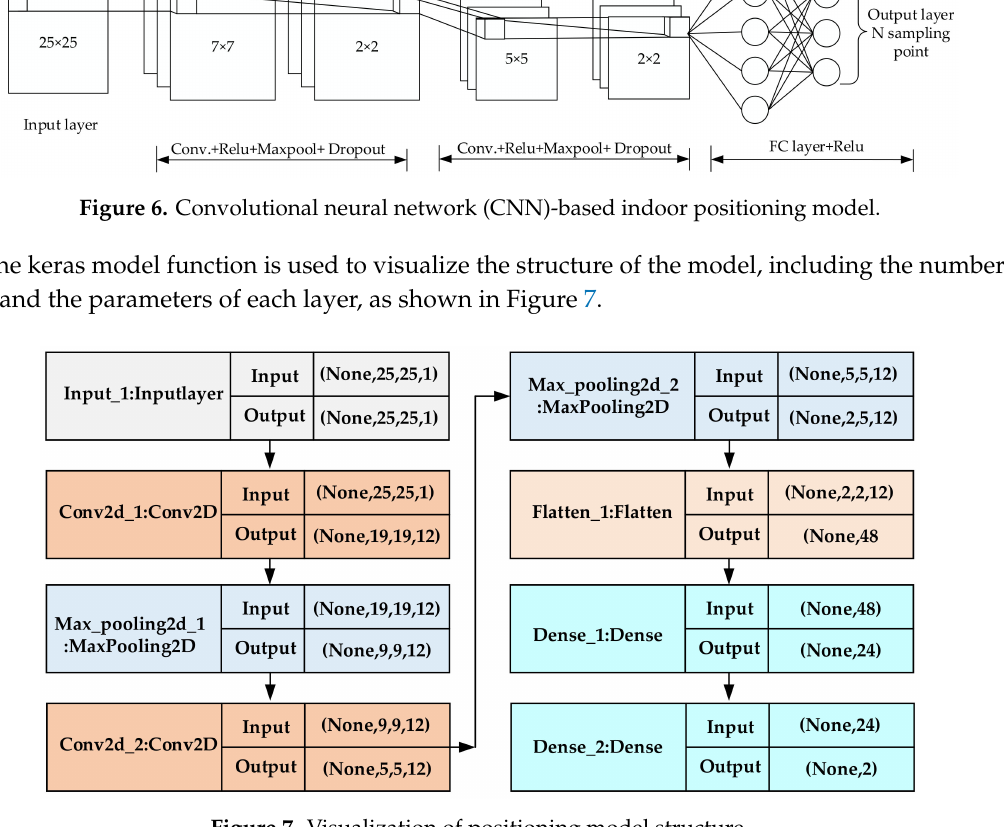
Figure 7. Visualization of positioning model